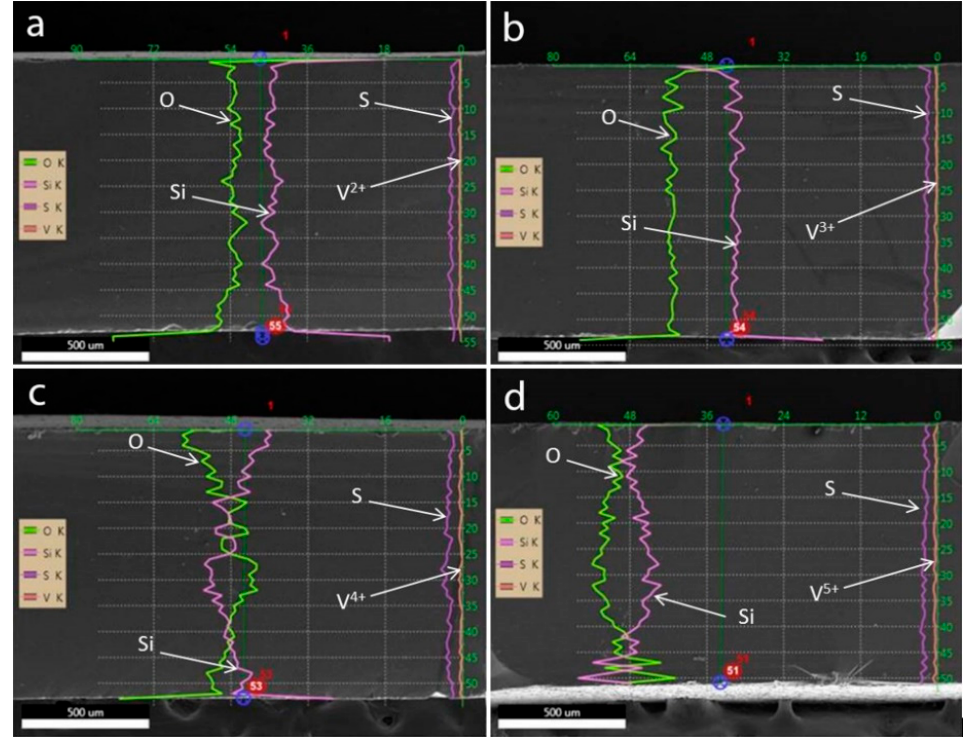
Figure 3. Results of EDS line-scan along the thickness of the VPG samples after equilibration in solutions of different vanadium ions: ( a ) V 2+ , ( b ) V 3+ , ( c ) VO 2+ , and ( d ) VO 2+ solution in 2 M H 2 SO 4 , respectively.